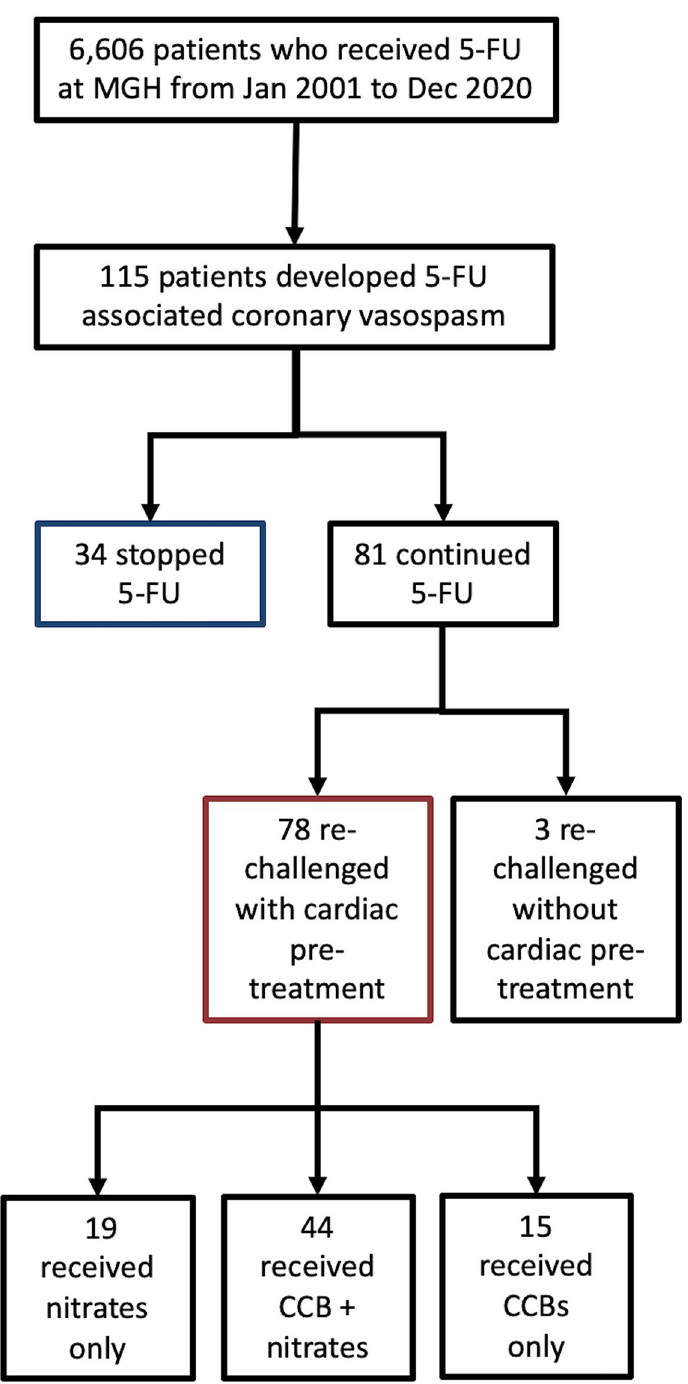
Fig 2. Summary of treatment assignments for 5-FU (Fluorouracil) associated coronary vasospasm patients. Summary of treatment assignments for all patients who developed 5-FU (Fluorouracil) associated coronary vasospasm.